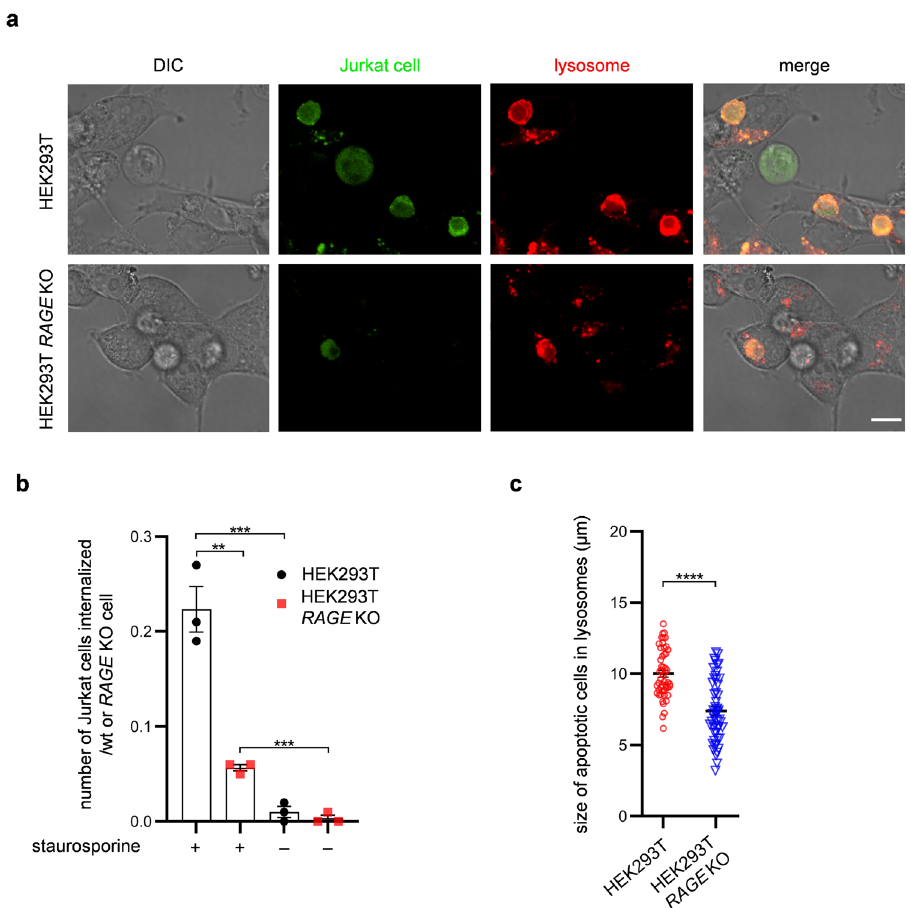
Fig. 8 RAGE is required for the internalization of apoptotic Jurkat cells in HEK293T cells. a Representative images of HEK293T or HEK293T RAGE KO cells with internalized apoptotic Jurkat cells expressing GFP obtained with differential interference contrast (DIC) or fl uorescence microscopy (apoptotic cell and lysosome). Lysosomes were stained with LysoTracker Red. Scale bar, 10 µ m. b Internalization of apoptotic Jurkat cells in HEK293T or HEK293T RAGE KO cells. Apoptotic cells were incubated with HEK293T or HEK293T RAGE KO cells at 10 6 Jurkat cells/4 – 6 × 10 5 wild-type or RAGE KO cells/ml. n = 3. c Distribution of size of Jurkat cell (fragment) internalized in HEK293T ( n = 50) or HEK293T RAGE KO ( n = 50) cells. The size was determined by measuring the longest dimension of internalized cells. Data were presented as the mean ± SEM ( b ). Statistical signi fi cance was determined by two-tailed unpaired Student ’ s t -tests ( b , c ). ** P < 0.01; *** P < 0.001; **** P <